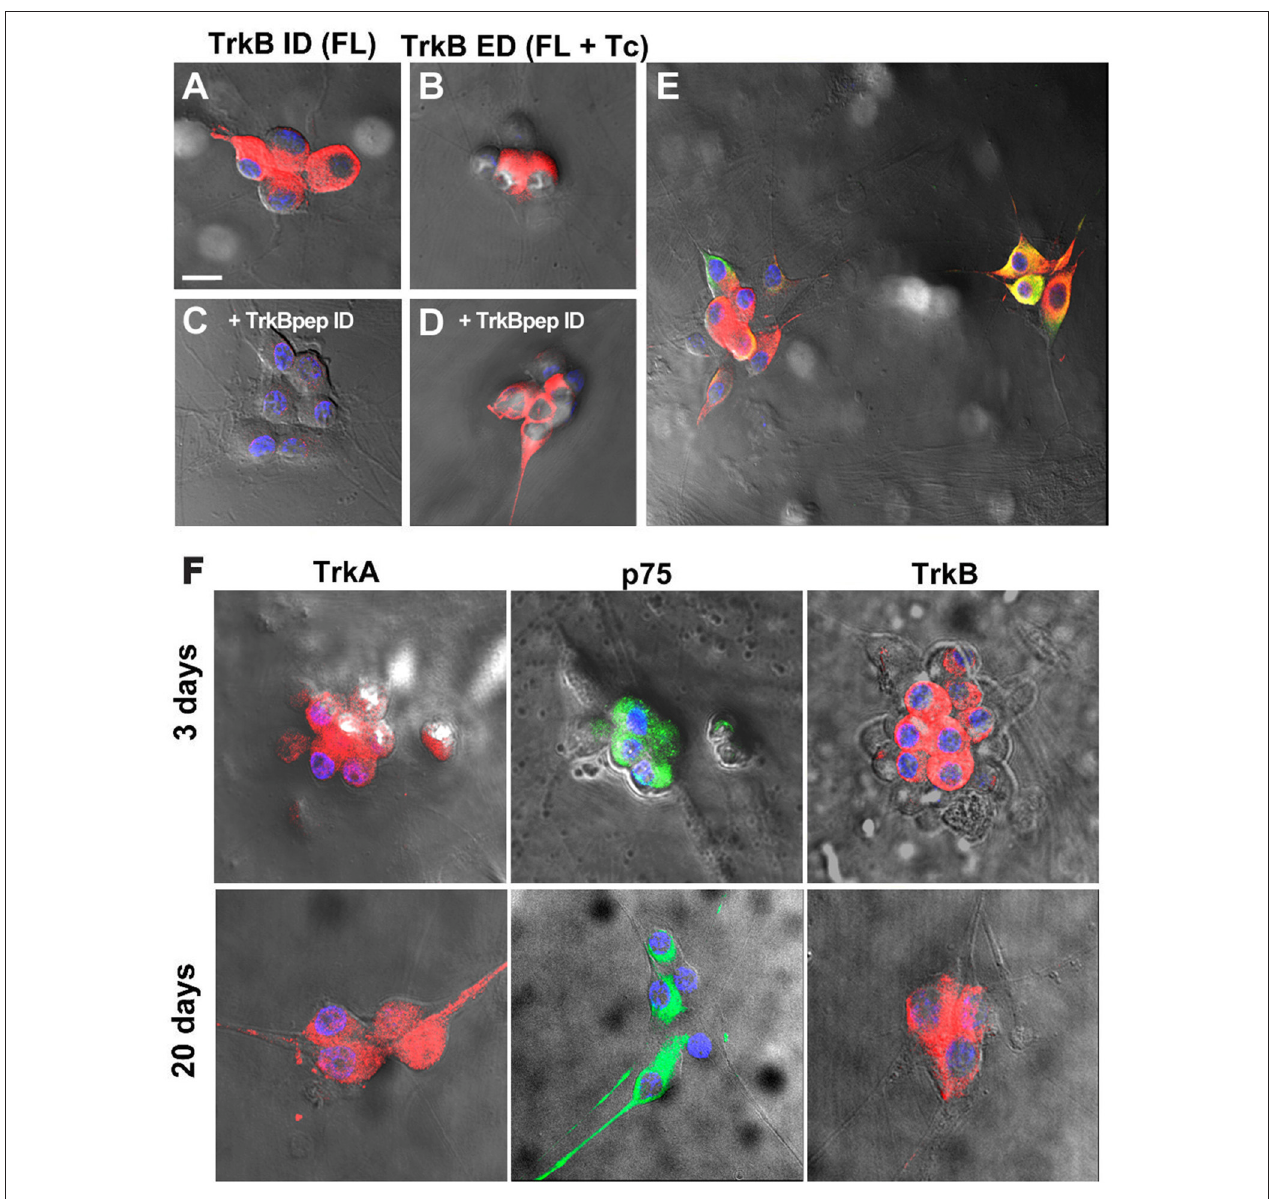
FIGURE 4 | Ganglionic neurons of neonatal rats co-cultured with cardiomyocytes expressed TrkA, p75NTR, and TrkB-Fl. Neonatal co-cultured neurons immunolabeled for the intracellular domain of TrkB (specific for the TrkB-Fl isoform) (A) and for the extracellular domain (occurring in both TrkB isoforms) (B) . Pre-adsorption of the primary antibody against TrkB-ID with the corresponding peptide (1:10) removed labeling for the intracellular TrkB domain (C) but not for TrkB-ED (D) , thus confirming the specificity of the antibody. TrkB-Fl + neurons were identified as sympathetic neurons through the co-expression of TH (E) . Scale bar = 30 µ m. n = 4. Neurotrophin receptor expression is similar in SCG co-cultures in 3- and 20-days post culture preparations. Figure shows the expression of TrkA, p75NTR, and TrkB-Fl in SCG neurons at 3 DIV and 20 DIV (F) . n = 4. All cultures were counterstained with DAPI (blue). Scale bar = 25 µ m. Supplementary material shows a 3D reconstruction of neurons immunostained with TrkB (red) and p75NTR (green) antibodies, and DAPI counterstaining (blue); video1 (merge), video2 (separated